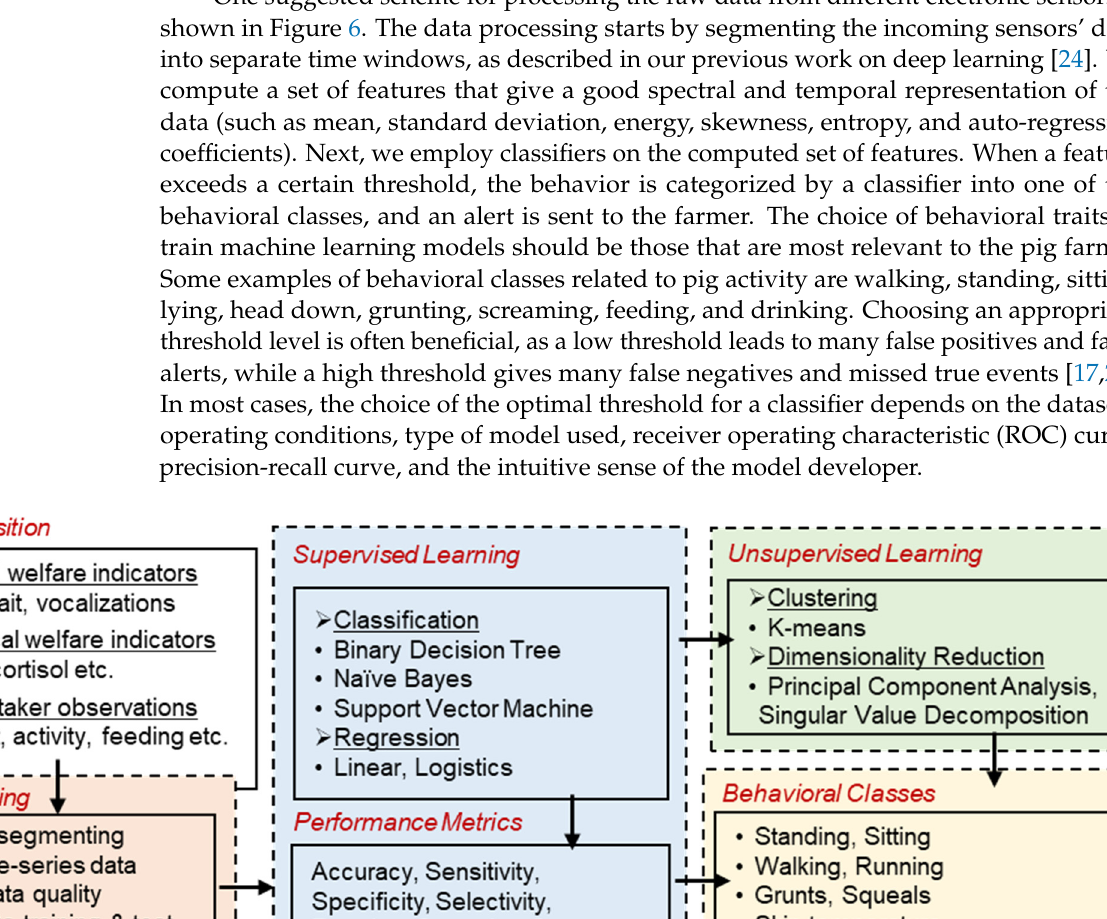
Figure 5. Flowchart for metrics, behavioral outcomes, and indicators of poor well-being.